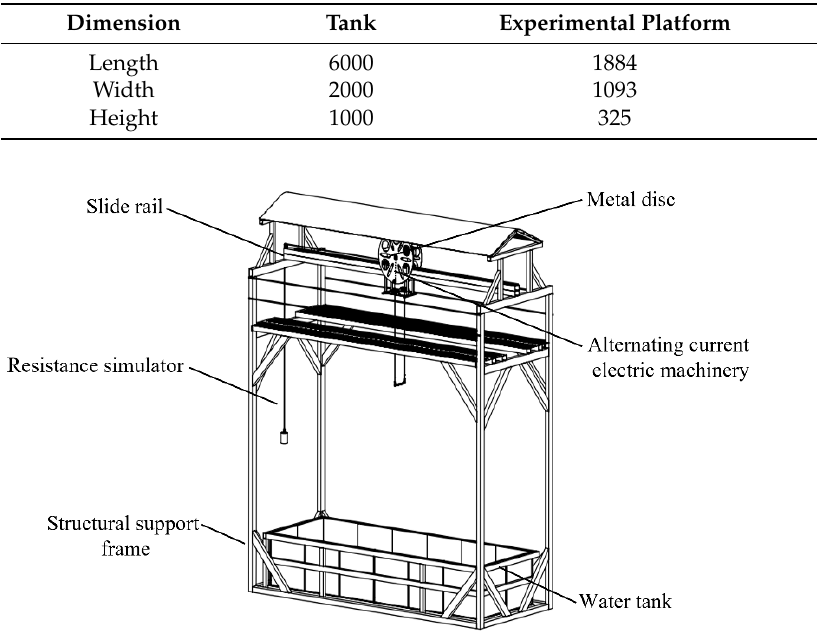
Figure 20. The large-scale wave simulation experiment platform.